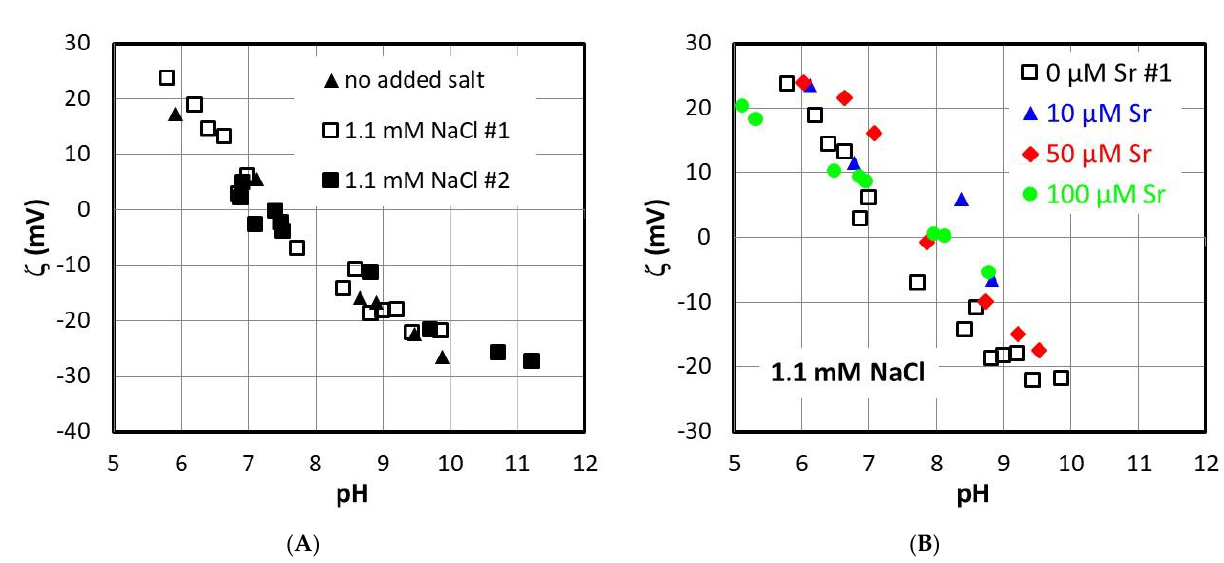
Figure 3. Zeta-potential measurements of the synthesized particles: ( A ) in the absence of Sr without NaCl addition or with 1.1. mM NaCl present. ( B ) in the absence and presence of 10, 50, and 100 µM Sr in 1.1 mM NaCl. The two series with 1.1 mM NaCl (i.e., #1 and #2 in ( A ) correspond to two separate series of experiments.